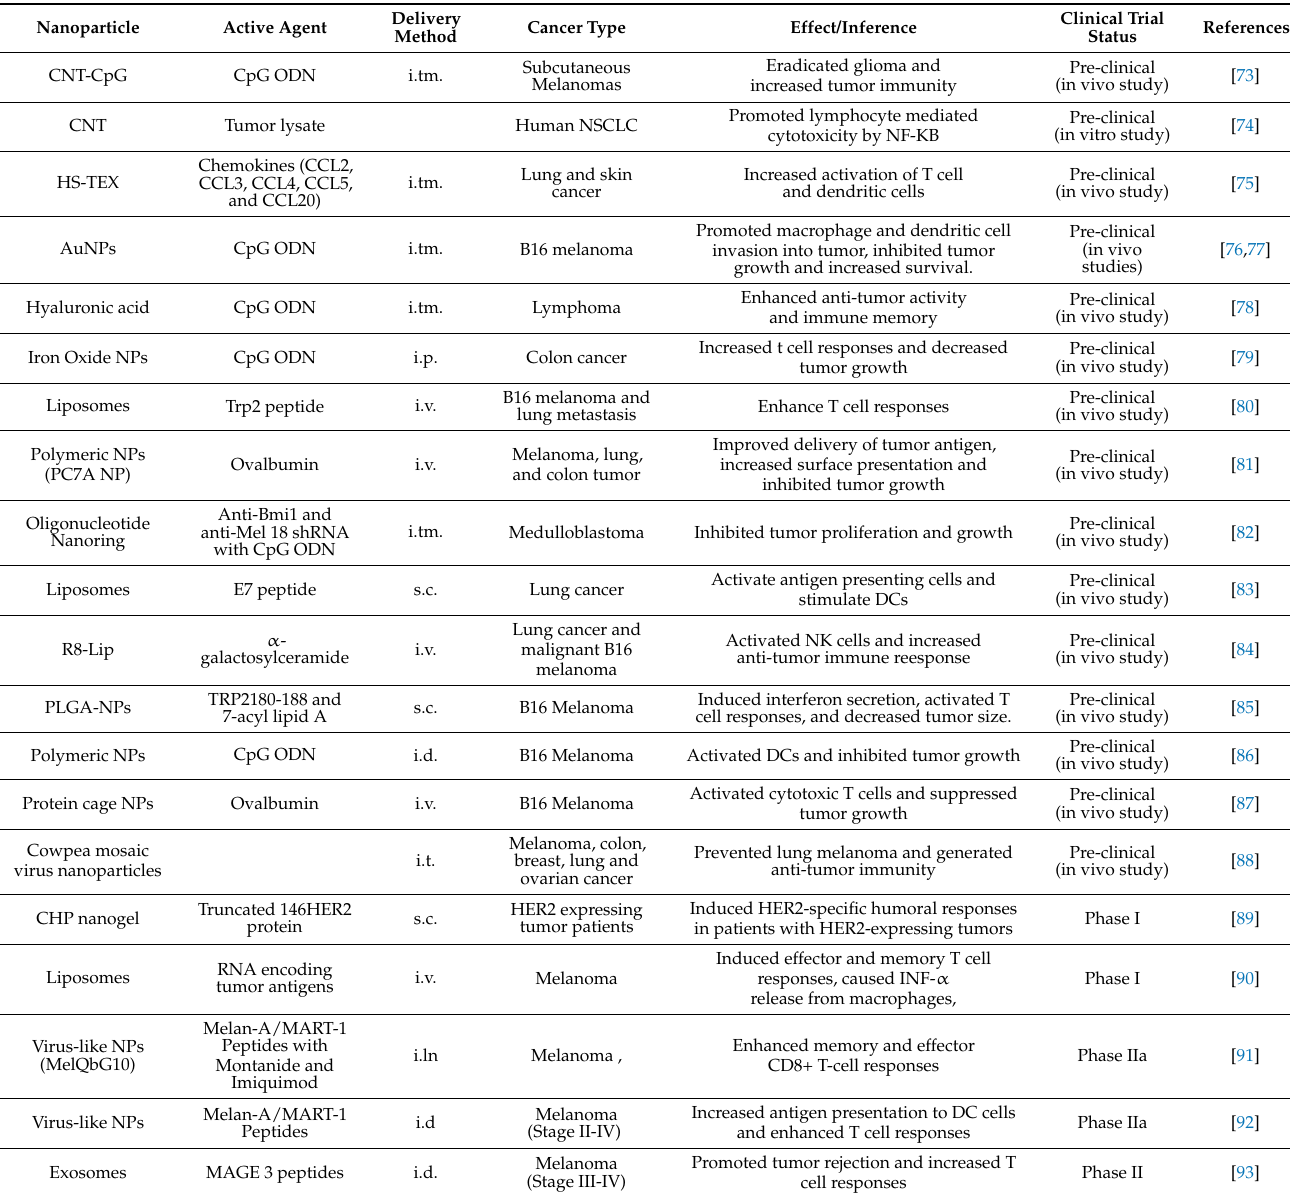
Table 2. Advances of Nanotechnology in